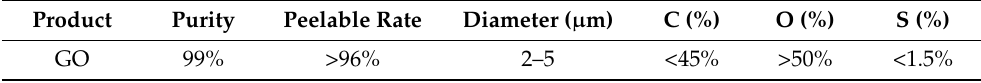
Table 2. Experimental GO